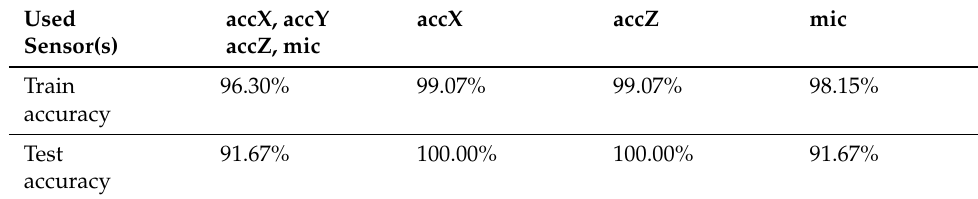
Table 4. Accuracy of the hybrid LSTM model (one LSTM